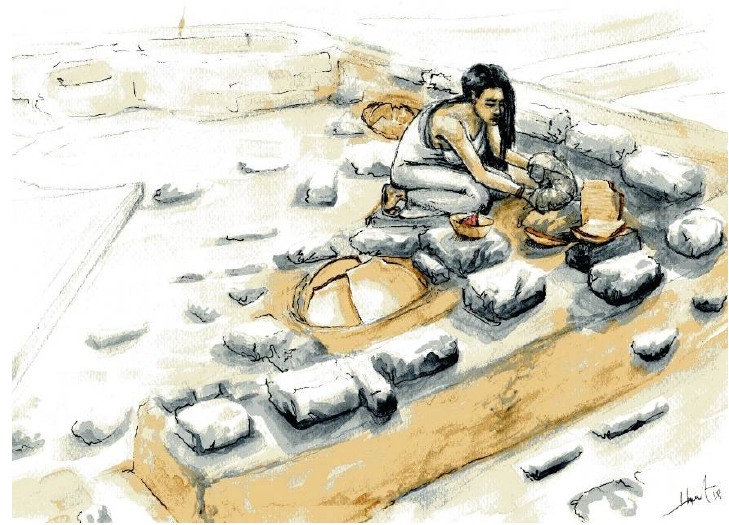
Figure 16. Artistic rendering showing the interment of one of the infant jar burials in the southeastern corner of the Western Compound Omphalos Building courtyard (drawing by Umut Kambak).